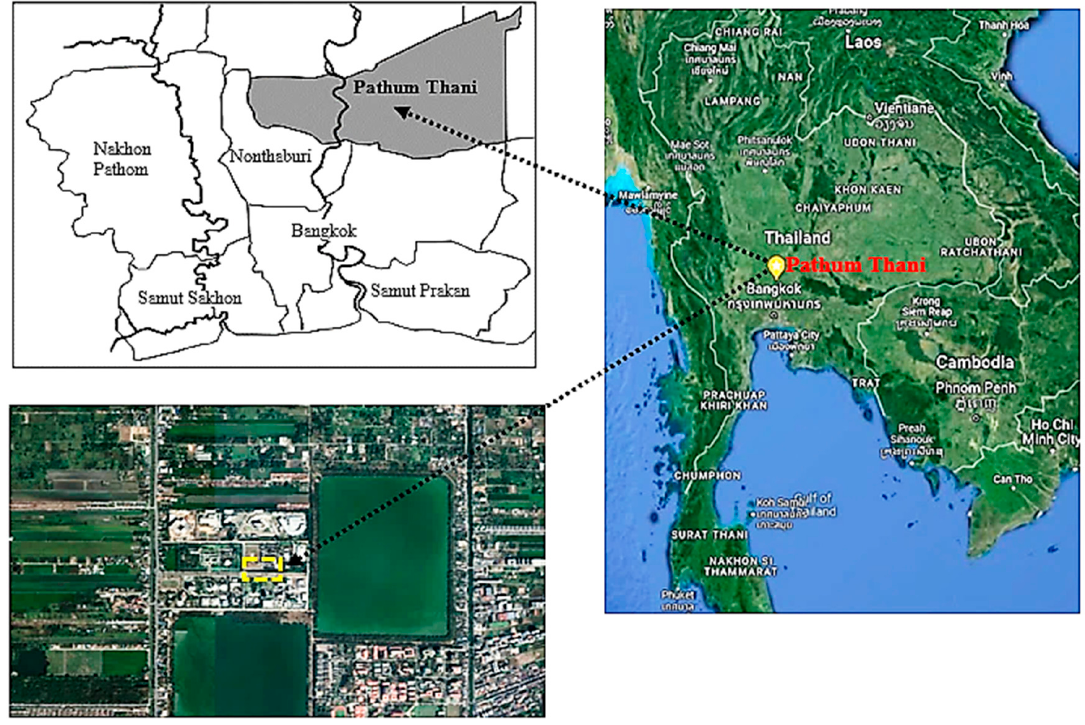
Figure 1. Location of sampling site.